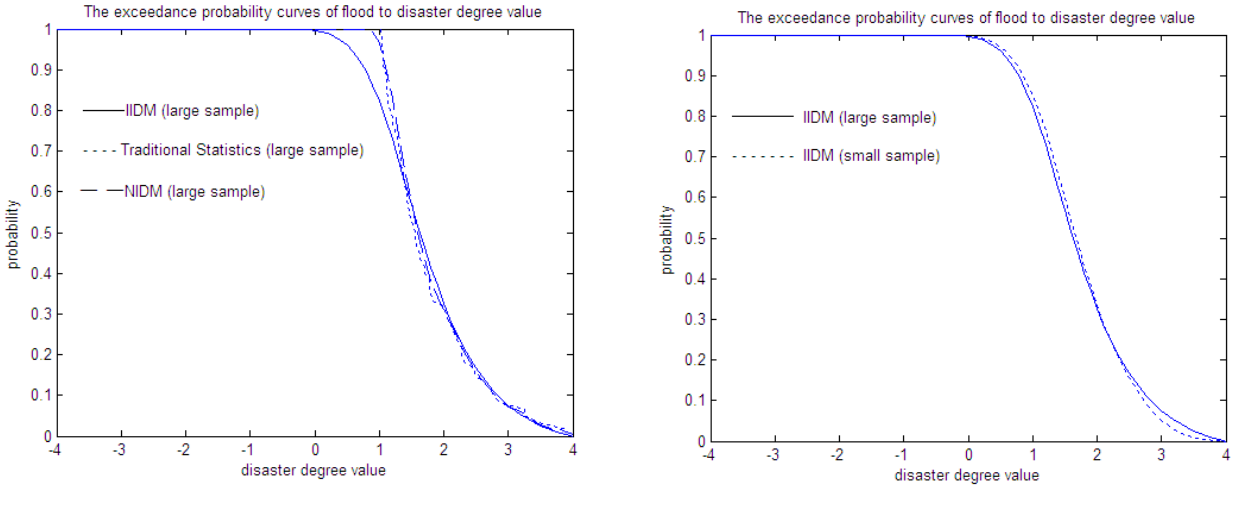
Fig. 3 comparisons of the risks by IIDM, the traditional statistical method, and NIDM 685 Fig. 3. Comparisons of the risks by IIDM, the traditional statistical method, and NIDM.